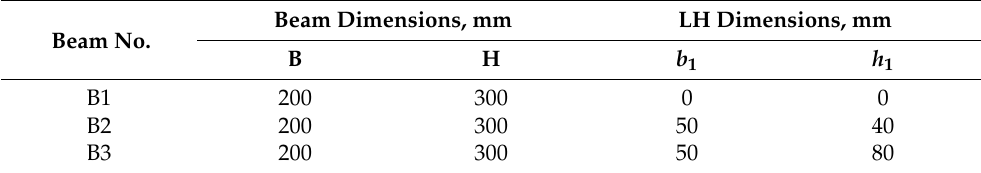
Table 2. Details of the tested RC beams. Beam No.